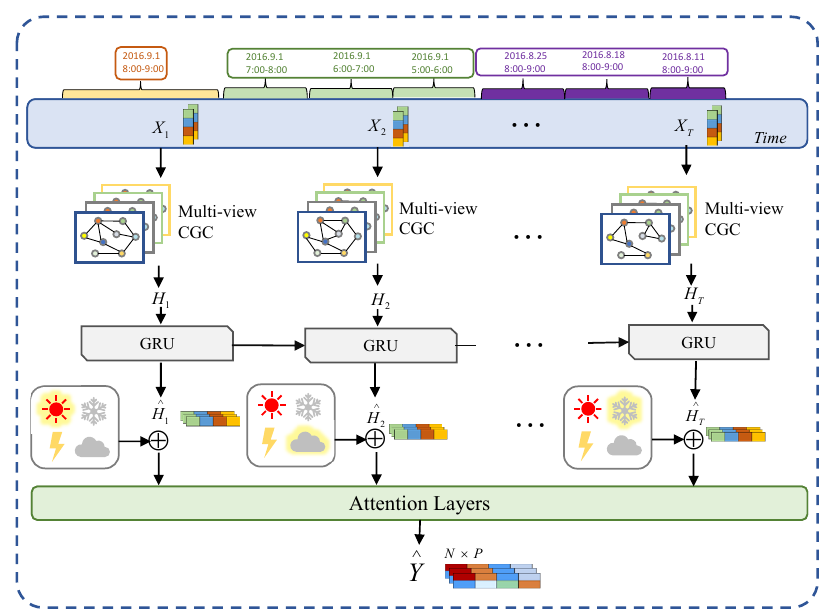
Figure 3. The overall framework of the DMV-GCN